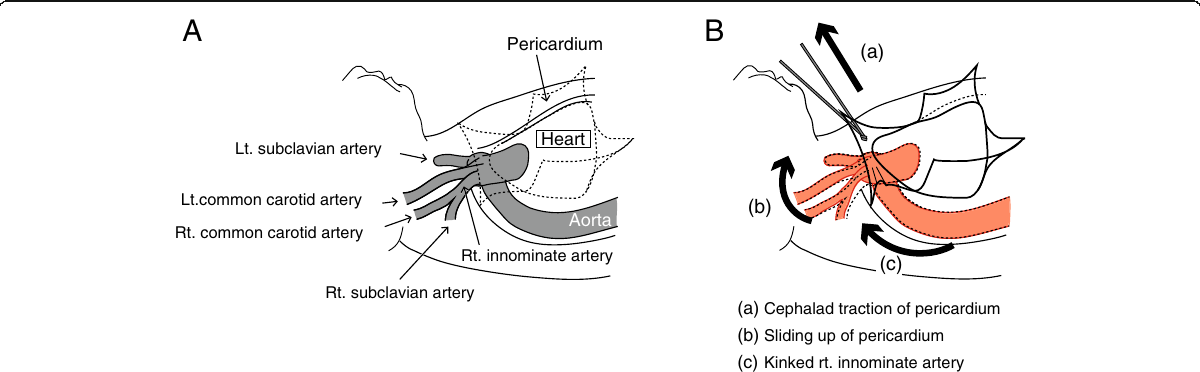
Fig. 2 Schematic of our hypothesis. Anatomical images of the aortic root and the pericardium ( A ) and obstruction of the right innominate artery by pericardium traction ( B ). Cephalad traction of the pericardium (a) moves the aortic root to the cephalad ventral direction (b) and obstructs the right innominate artery (c). Rt, right; Lt,